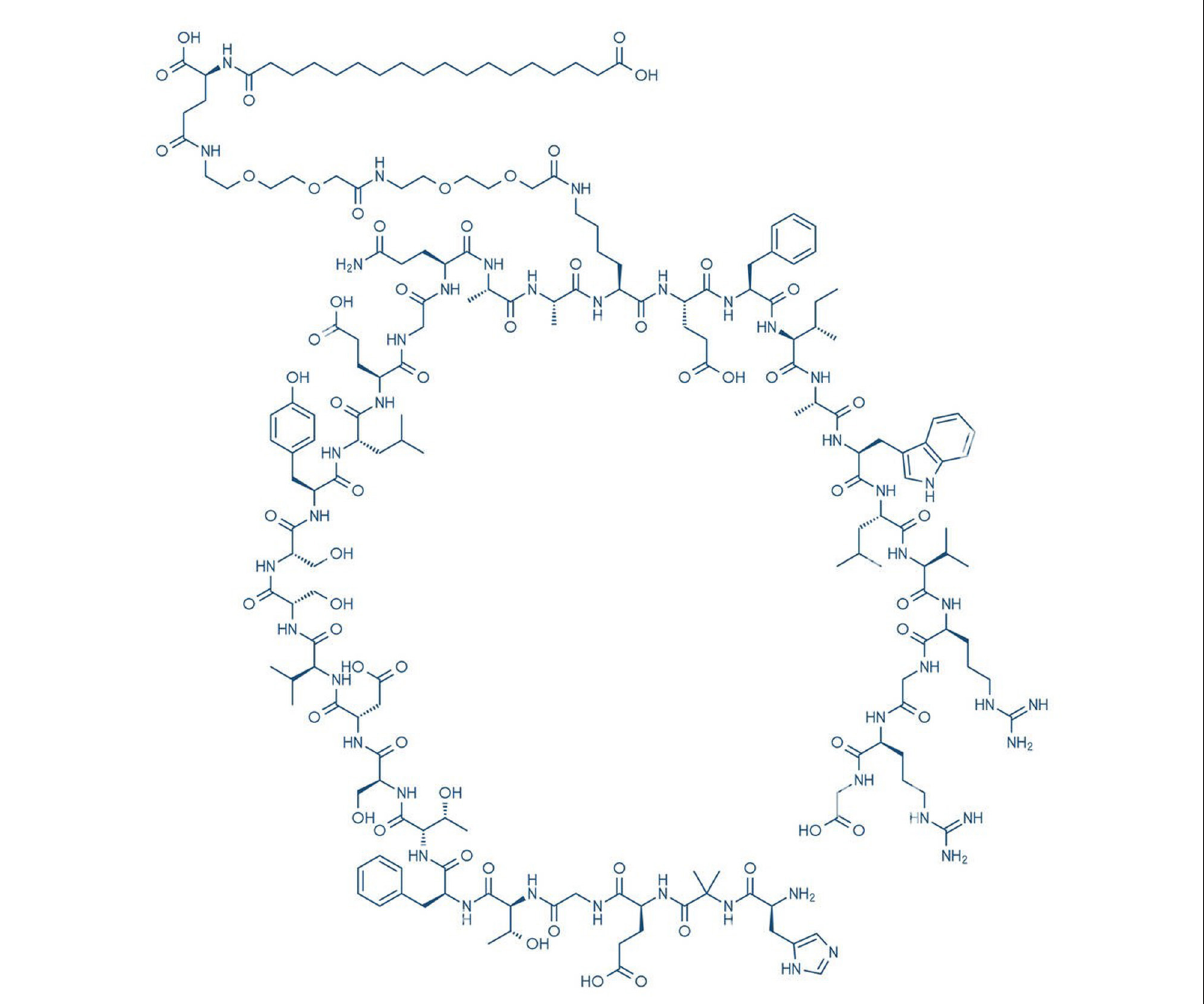
FIGURE3 Chemical structure of